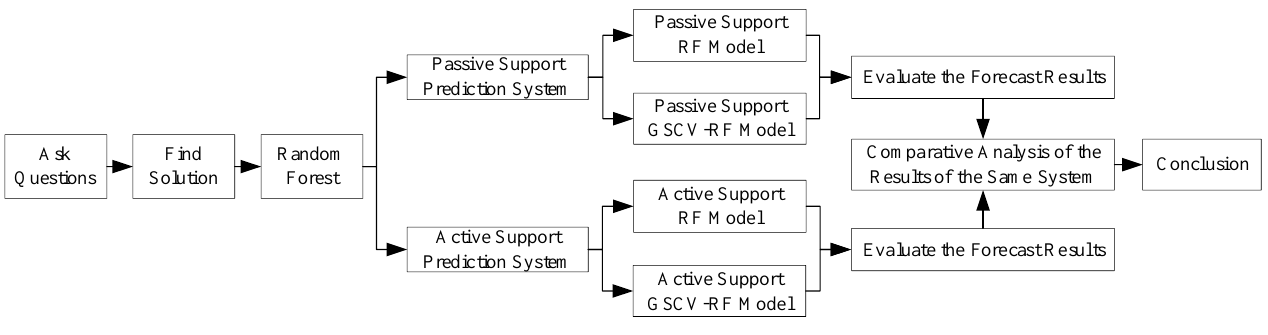
Figure 1. Workflow of this